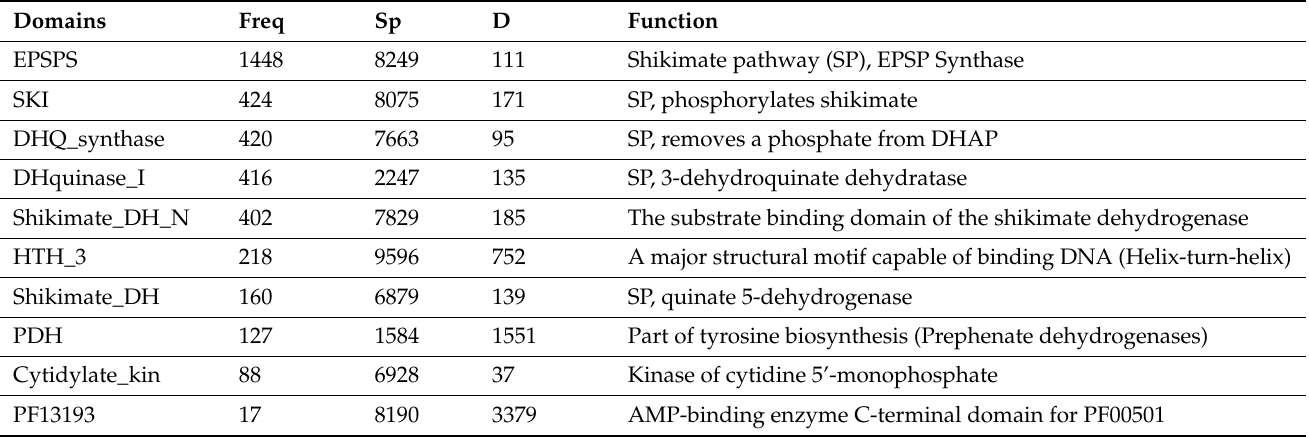
Table 1. Most common functions of the EPSPS-associated